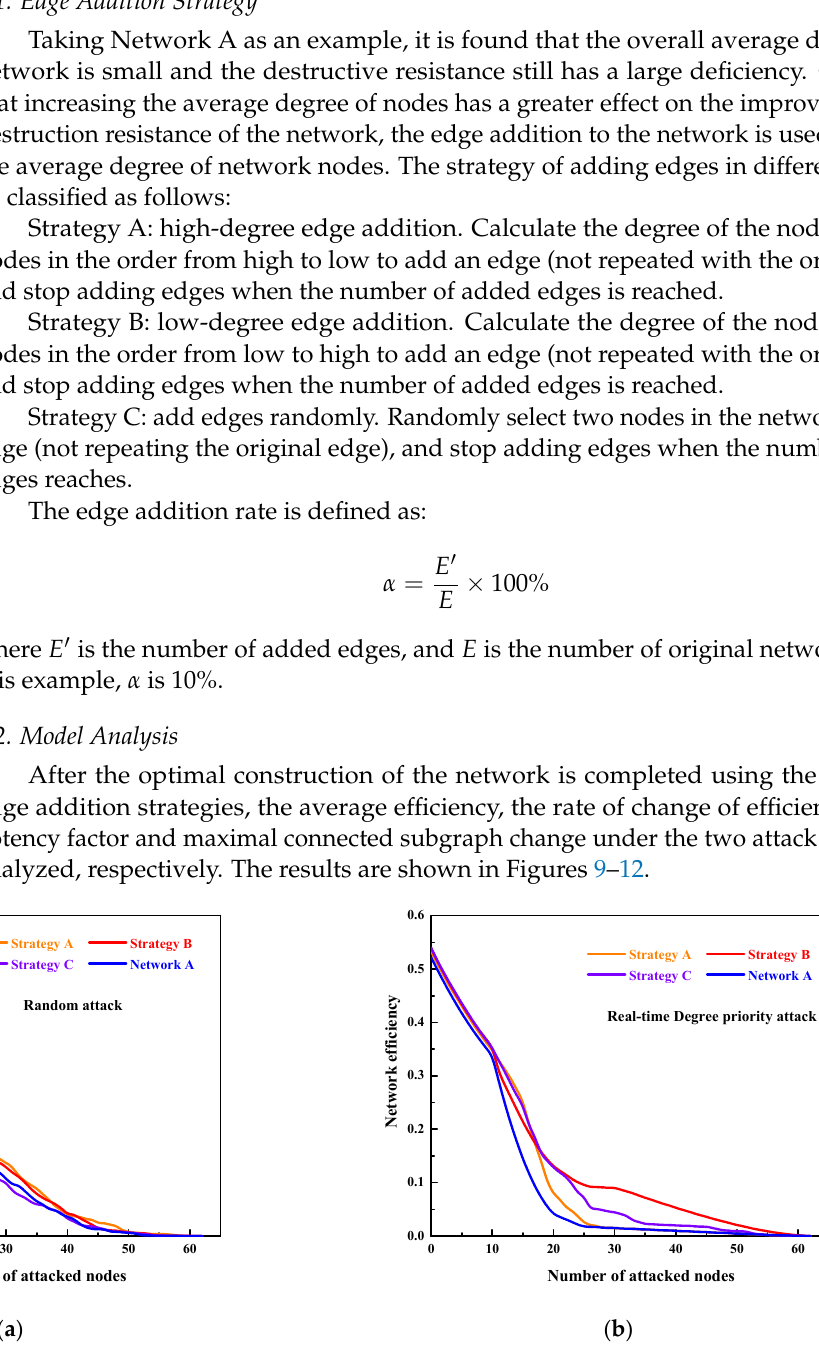
Figure 9. Graph of the average efficiency under two attacks. ( a ) Random attack; ( b ) Deliberate attack.